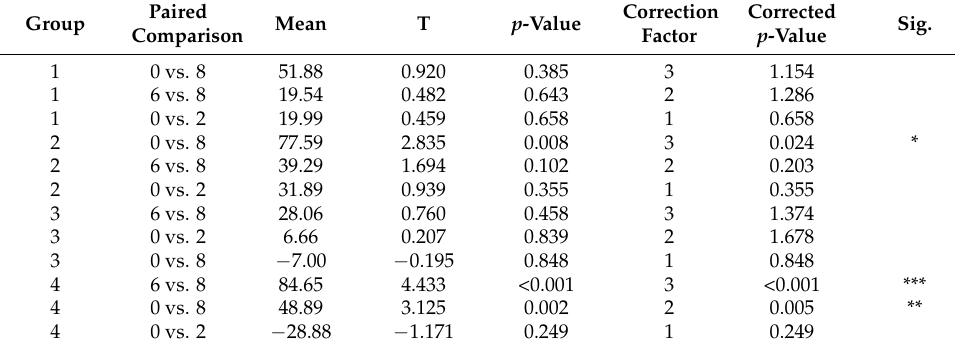
0 vs. 2 − 28.88 0.249 CfDNA levels were compared between baseline and 2 months, baseline and 8 months, and 6 and 8 months by paired t -tests for each group, respectively, which were corrected using the Bonferroni–Holm method. * p < 0.05, ** p < 0.01, *** p <